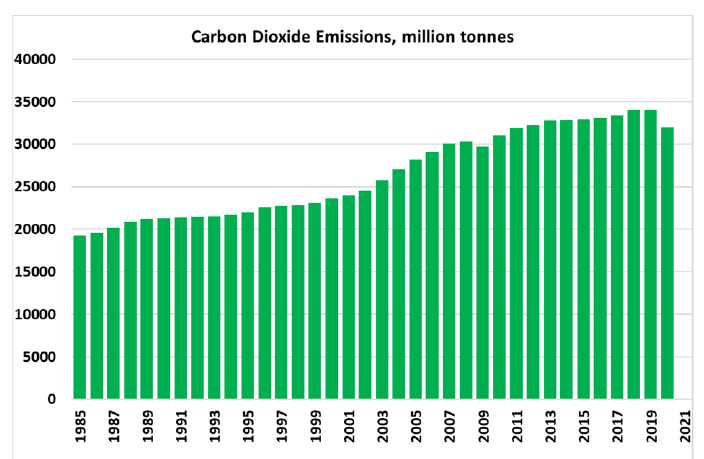
Figure 8. Primary Energy consumption, exajoules [5].